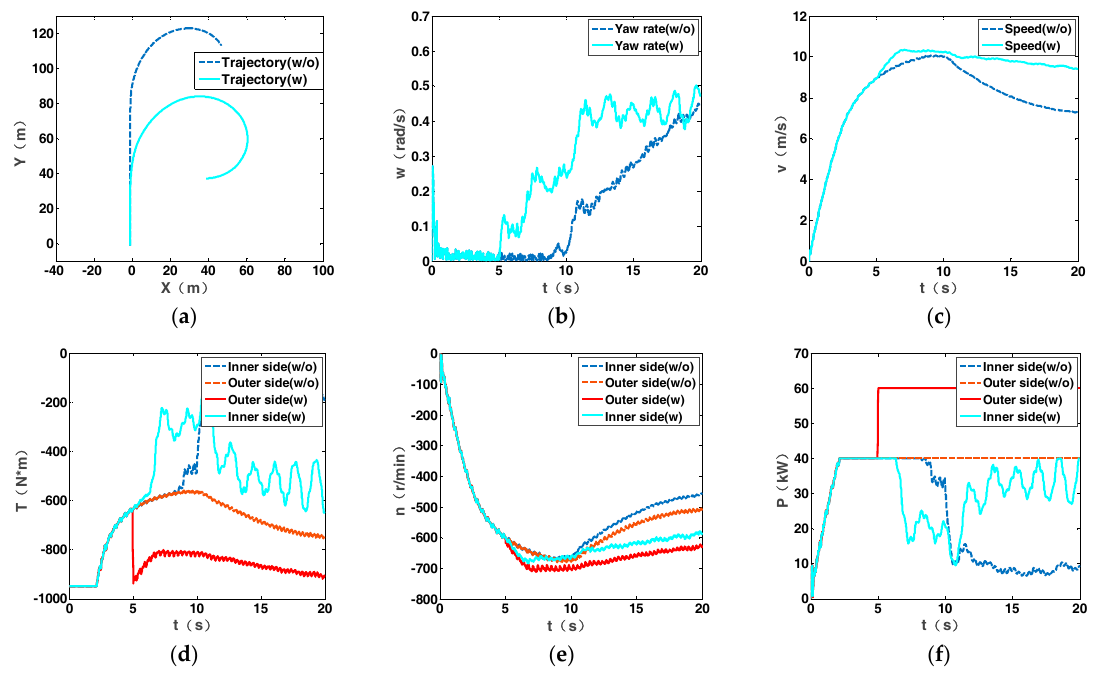
Figure 15. Simulation results of 8 B steering: ( a ) Trajectory; ( b ) Vehicle yaw rate; ( c ) Vehicle speed; ( d ) Sprocket torque; ( e ) Sprocket rotation speed ( f ) Sprocket power.